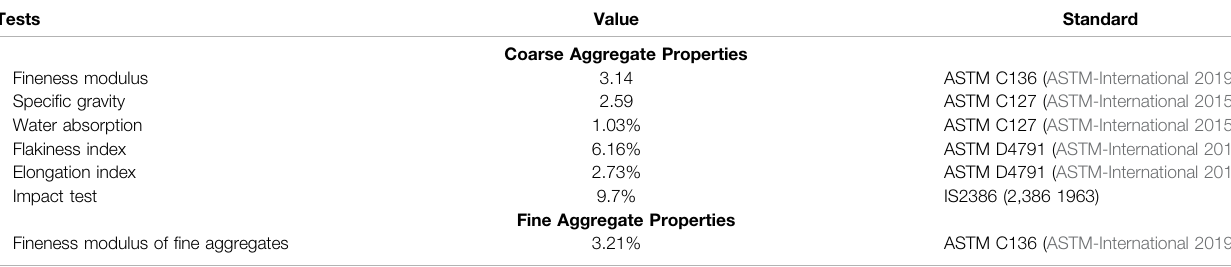
TABLE 1 | Properties of coarse and fi ne aggregates.